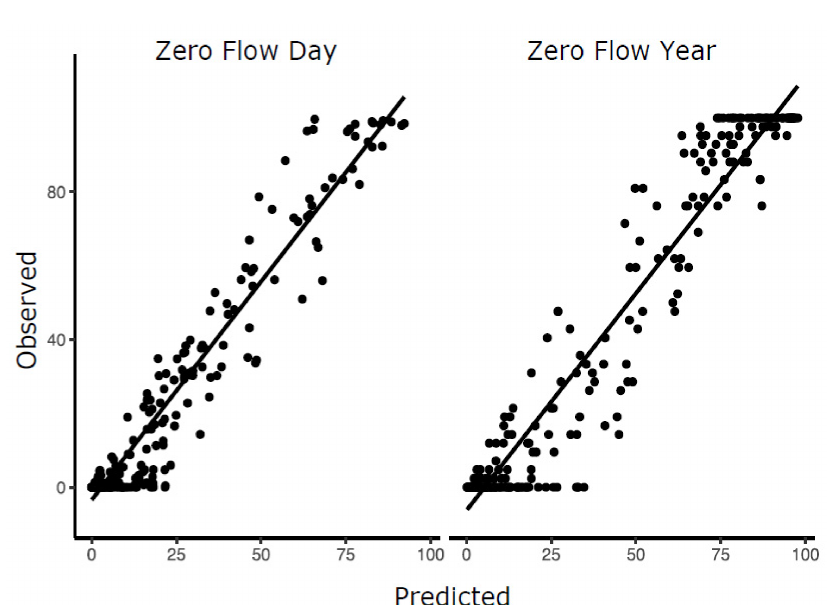
Figure 6. Plots of observed versus predicted values for the ZFY and ZFD regression